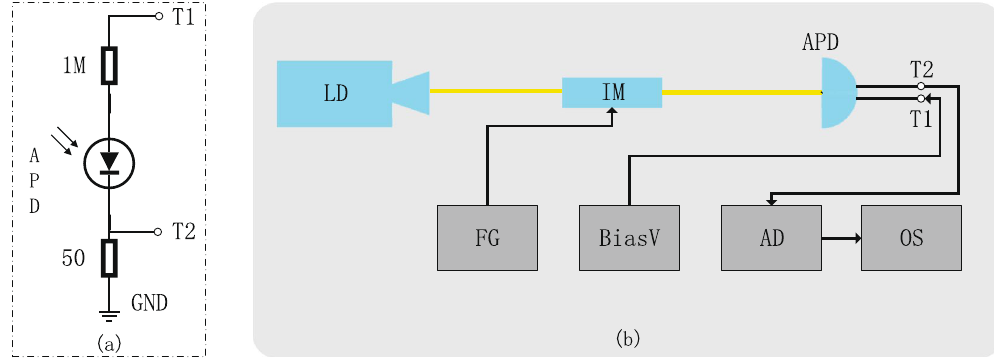
Figure 6. ( a ) Detector circuit diagram. Tap T1: analog tap of the APD bias voltage with a biased resistance of 1 MΩ. T2: analog tap of avalanche signals with a load resistance of 50 Ω. ( b ) LD: laser diode, IM: intensity modulator, FG: function generator, BiasV: home-made DC power, AD: amplifier discriminator, and OS: